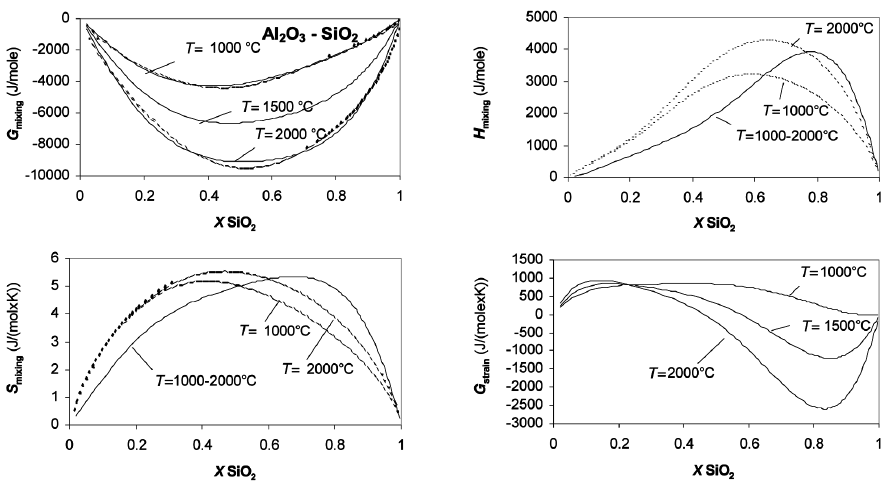
Fig. 10. HPM thermodynamic parameterization of Al 2 O 3 -SiO 2 system (solid lines; Ottonello and Moretti, 2004), compared with estimates of modified quasi -chemical model (dashed lines; Pelton et al. ,